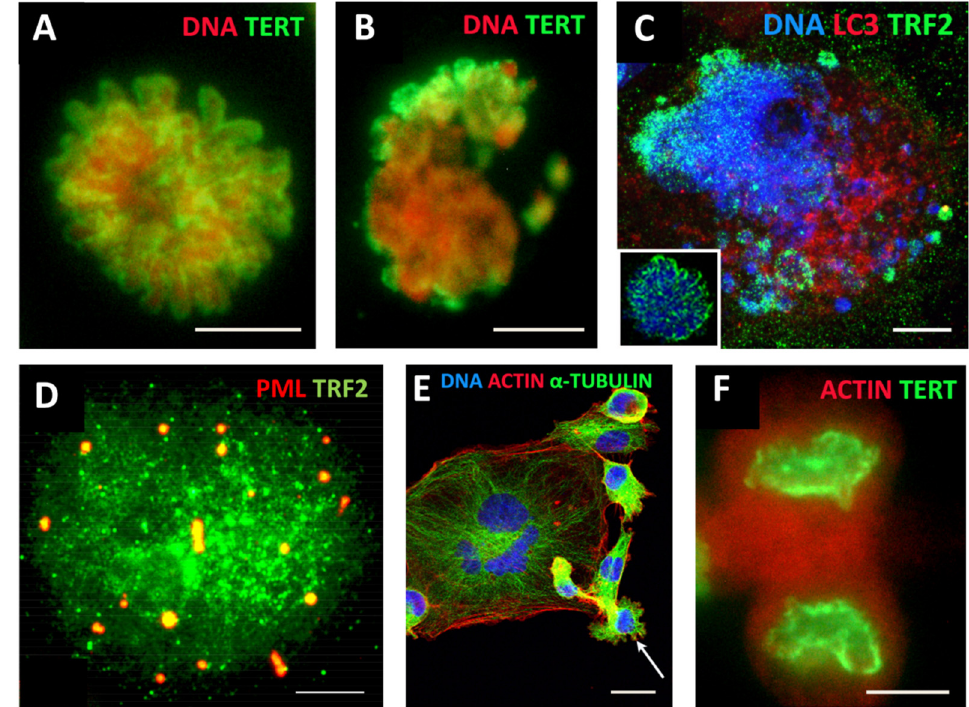
Figure 3. Mitotic slippage of the MDA-MB-231 breast cancer cell line. ( A ) TERT-positive metaphase in control cells (DNA counterstained by propidium iodide); ( B ) mitotic slippage with low TERT nuclear and enriched cytoplasmic DNA staining on Day 5 after DOX treatment; ( C ) preferential release of the telomere shelterin-TRF2-associated chromatin into the cytoplasm on Day 7 after DOX treatment (insert: normal metaphase); ( D ) polyploid cell marked by specific TRF2-positive PML bodies, suggesting the restoration of the telomeres by alternative telomere lengthening (ALT); ( E ) A giant multinuclear cell is budding subcells (arrow); ( F ) TERT-positive escape telophase cell on Day 22 after DOX treatment; Bars: ( A – D , F ) = 10 µm; ( E ) = 25 µm. Subfigures A–C,E,F are republished from [73] under Creative Commons Licence.